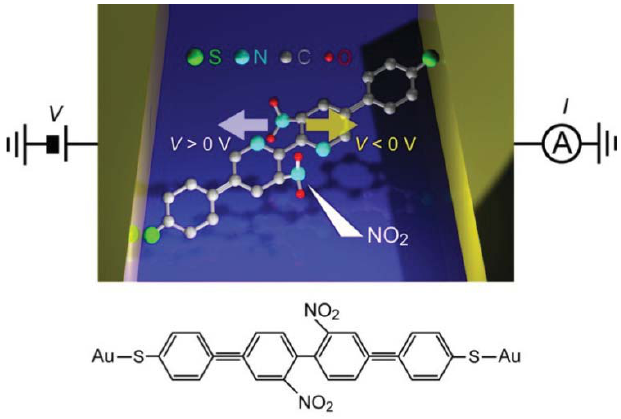
Figure 6. Bias voltage controlled bipolar binary conductance switching in single-molecule bipyridyl-dinitro oligophenylene-ethynylene dithiol sandwiched between Au nanoelectrodes. The conductance jumps to the on state at 0.8 V during sweeping the bias in the positive direction, which was attributed to conformational change of the dithiol molecule by the electrostatic forces originated from the electric field across the electrode gap at the dipole moments induced by the NO groups (white arrow). Subsequently, the junction conductance 2 was switched back to the off state by decreasing the bias voltage to (cid:4)1.0 V associated with the electrostatic force now acting in the opposite direction (yellow arrow) that reverses the conformational change. The on-off switching was reproduced in the successive voltage